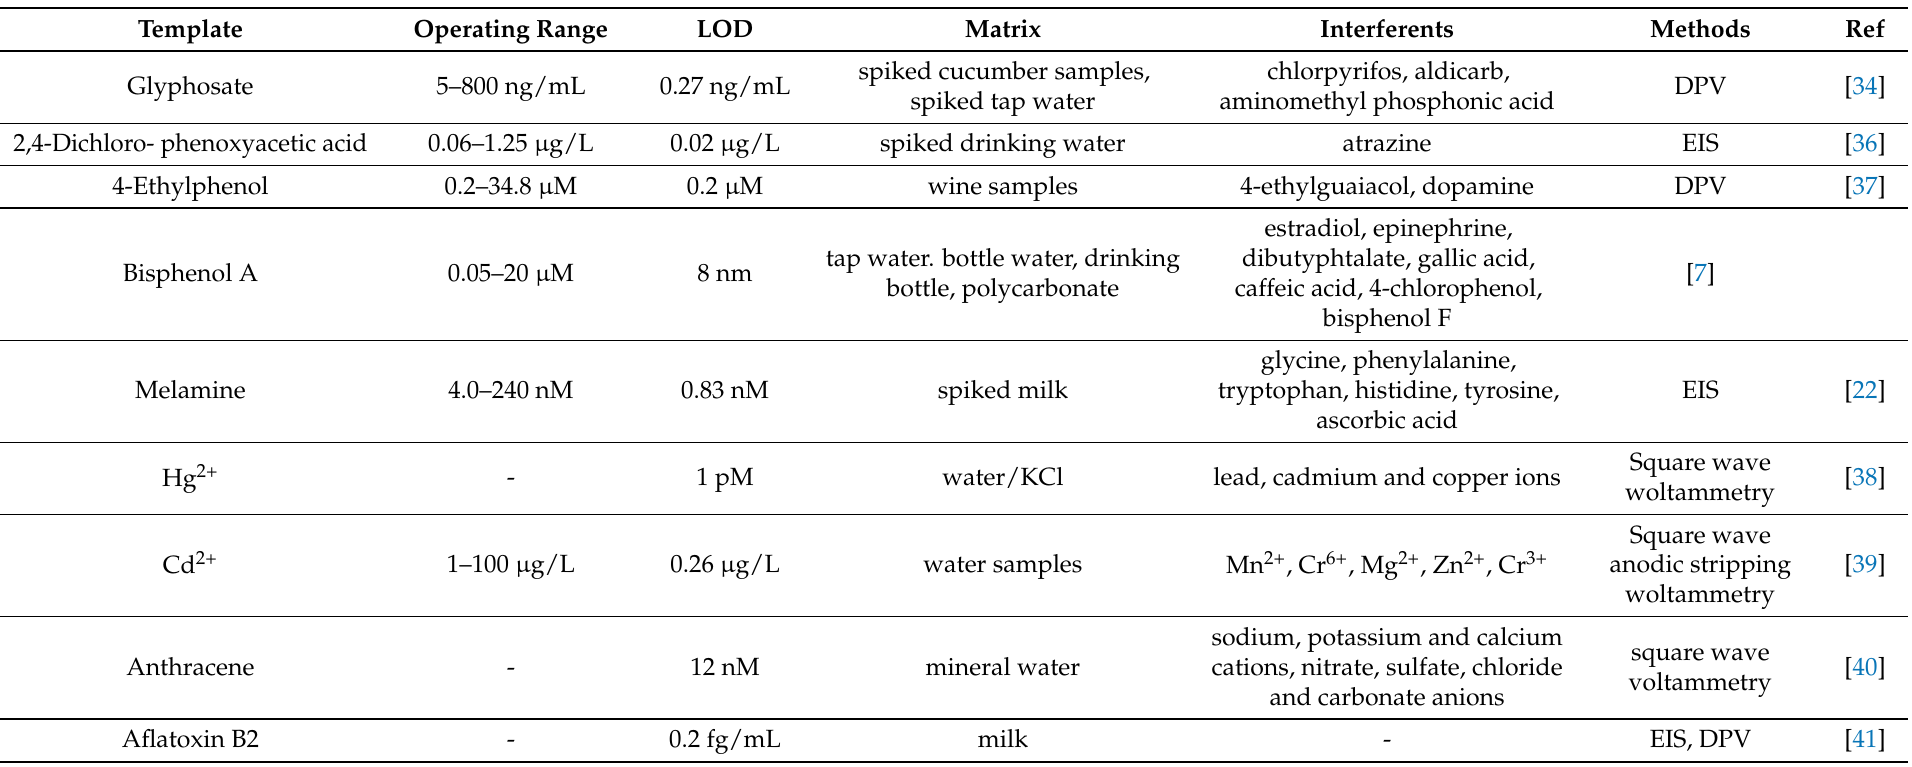
Table 2. Performance of MIPPy-based sensors for detecting of non-medical